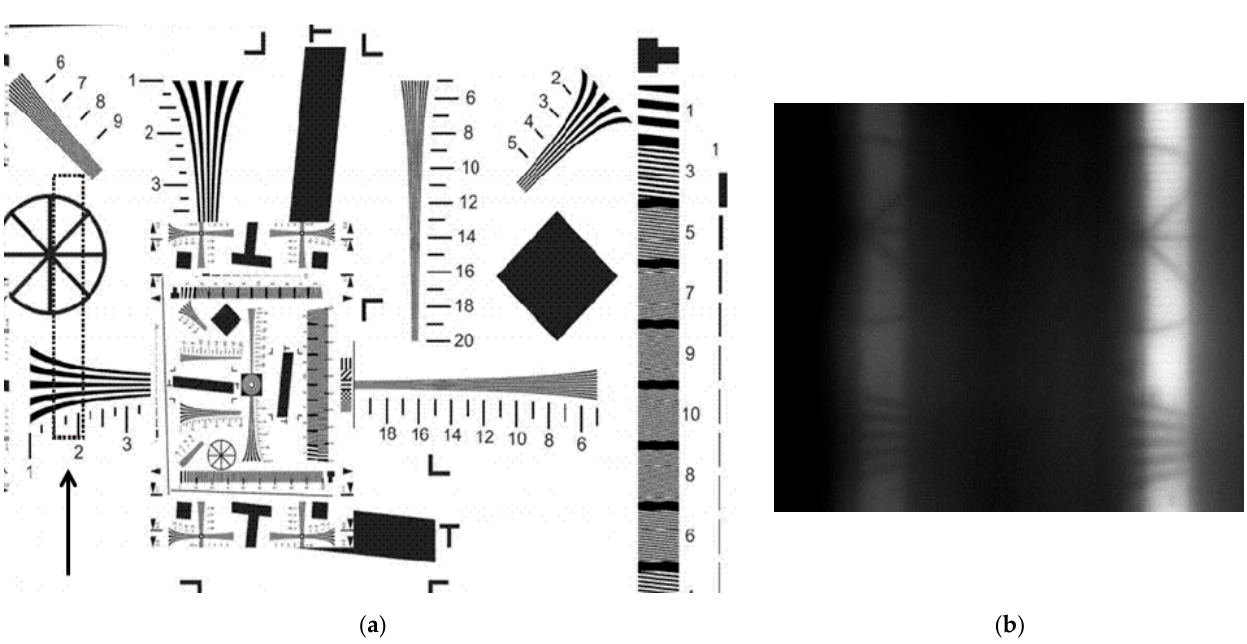
Figure 10. ( a ) An optical test pattern (the area covered is within a dashed-line rectangle and marked with an arrow) and ( b ) a fragment of the test pattern image obtained through a 315-um slit diaphragm, with the covered area marked by dashed lines.